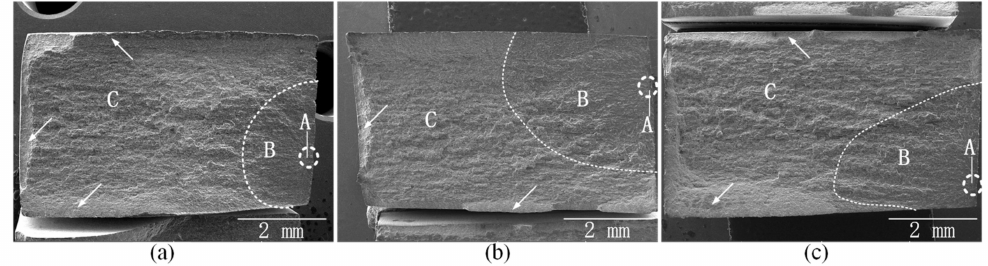
Fatigue fracture topography of 7075 aluminum alloy at di ff erent prebending radii